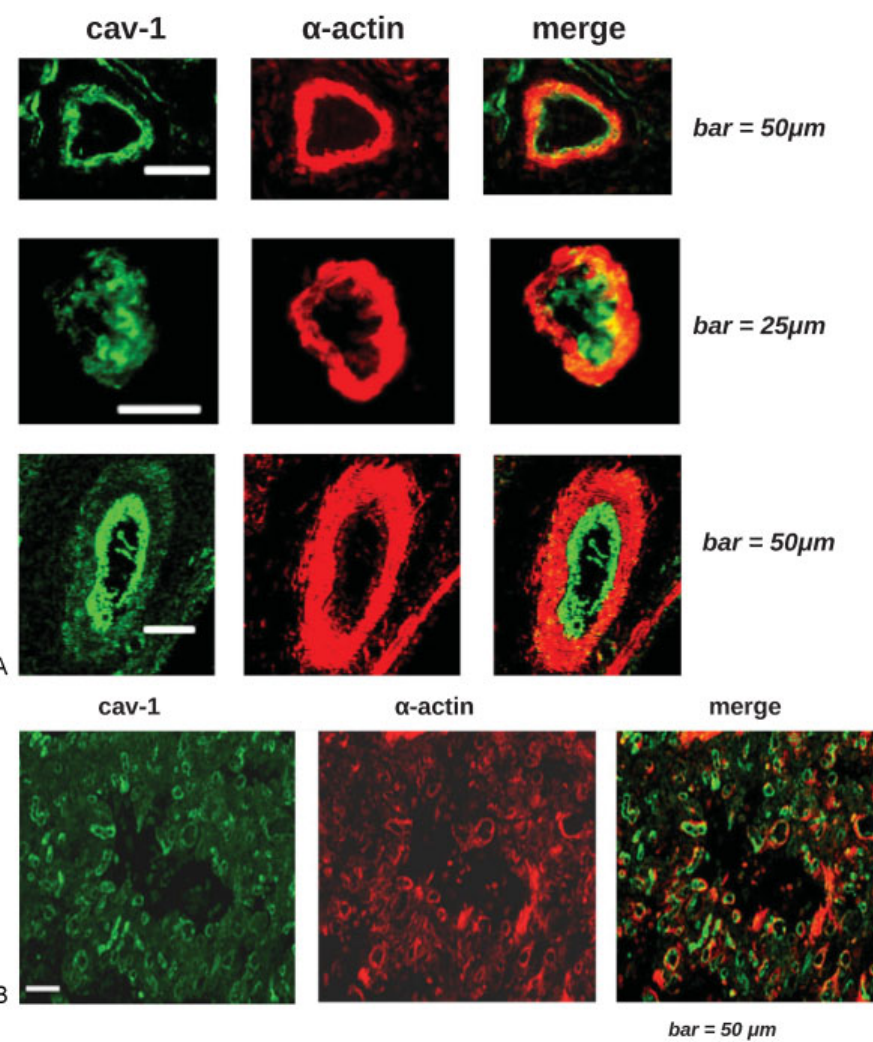
Fig. 4 Expression of caveolin-1 (green) and smooth muscle α -actin (red) in pulmonary arteries (A). The top panel shows thin intimal layer with well-preserved endothelial caveolin-1. The lower panels show a thickened intimal layer with well-preserved endothelial caveolin-1 and without endothelial disruption. In (B), small vessels with endothelial caveolin-1 (green) expression are seen. Several of these vessels lack the expression of smooth muscle α -actin